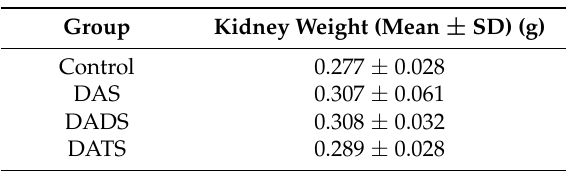
Table 1. The kidney weight in control and allyl sulfide–treated mice. Data are presented as the means ± SD of six animals in each group.